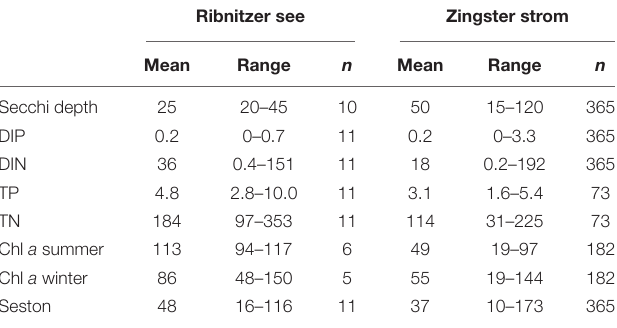
TABLE 1 | Mean and ranges of selected parameters characterizing the Ribnitzer See near the main freshwater inflow (most eutrophied) and the Zingster Strom (center of the eutrophication gradient) for 2014: Secchi depth (cm), DIP (phosphate, µ mol l − 1 ), DIN (dissolved inorganic nitrogen, sum of nitrate,